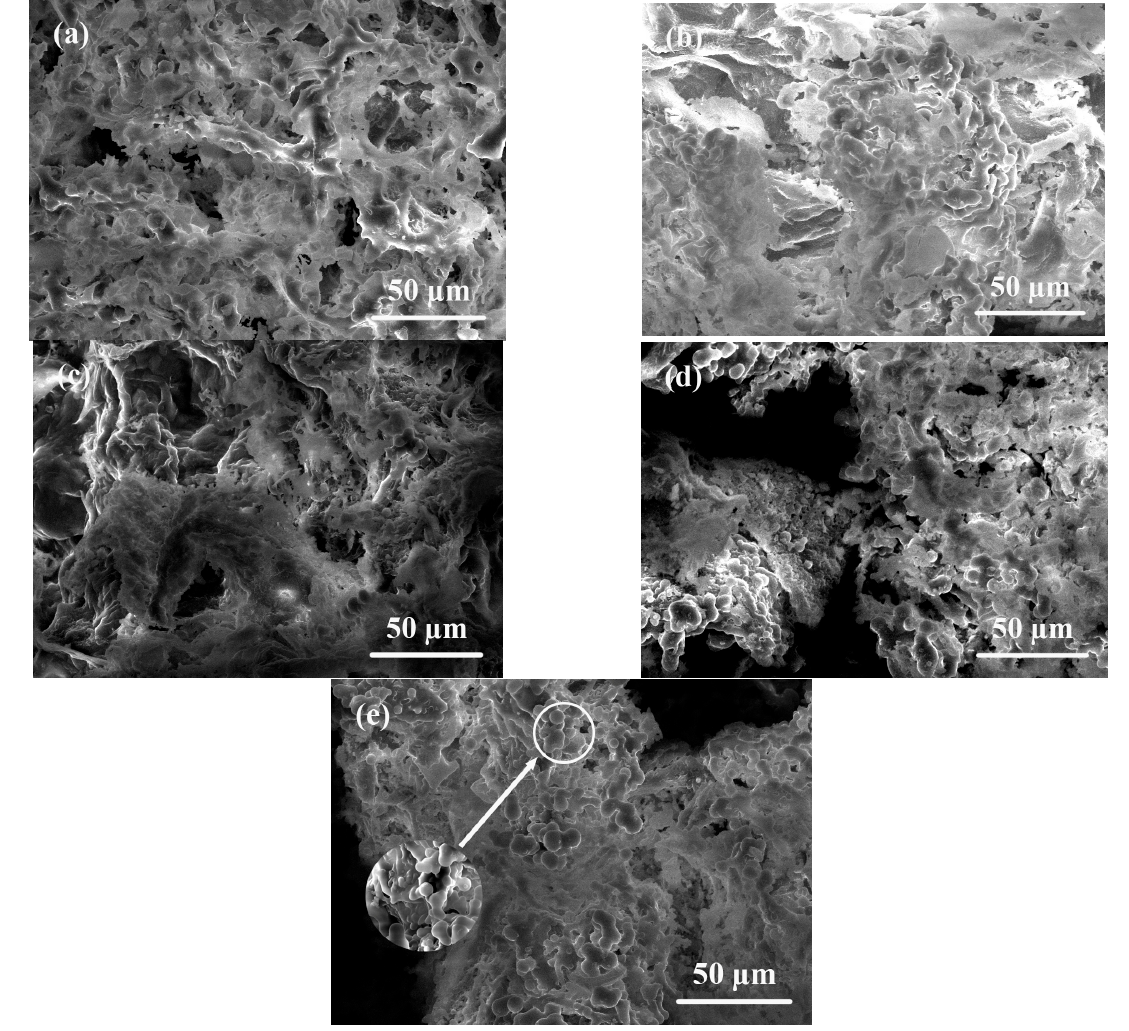
Figure 6. Scanning electron microscope (SEM) micrographs taken at 50 µm ( a – e ) and 10 µm (an image labeled in ( e )) of the hydrochar produced at increasing HTC temperatures (185–265 °C).